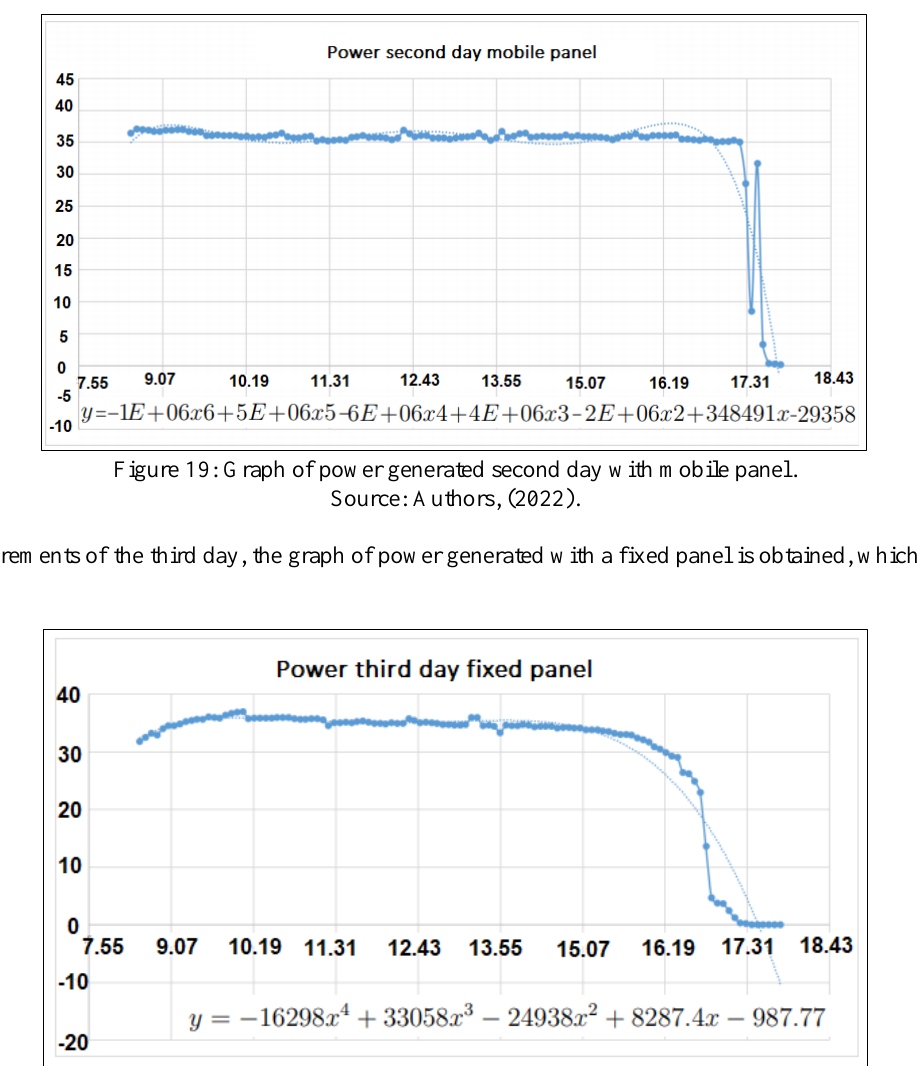
Figure 20: Graph of power generated third with fixed